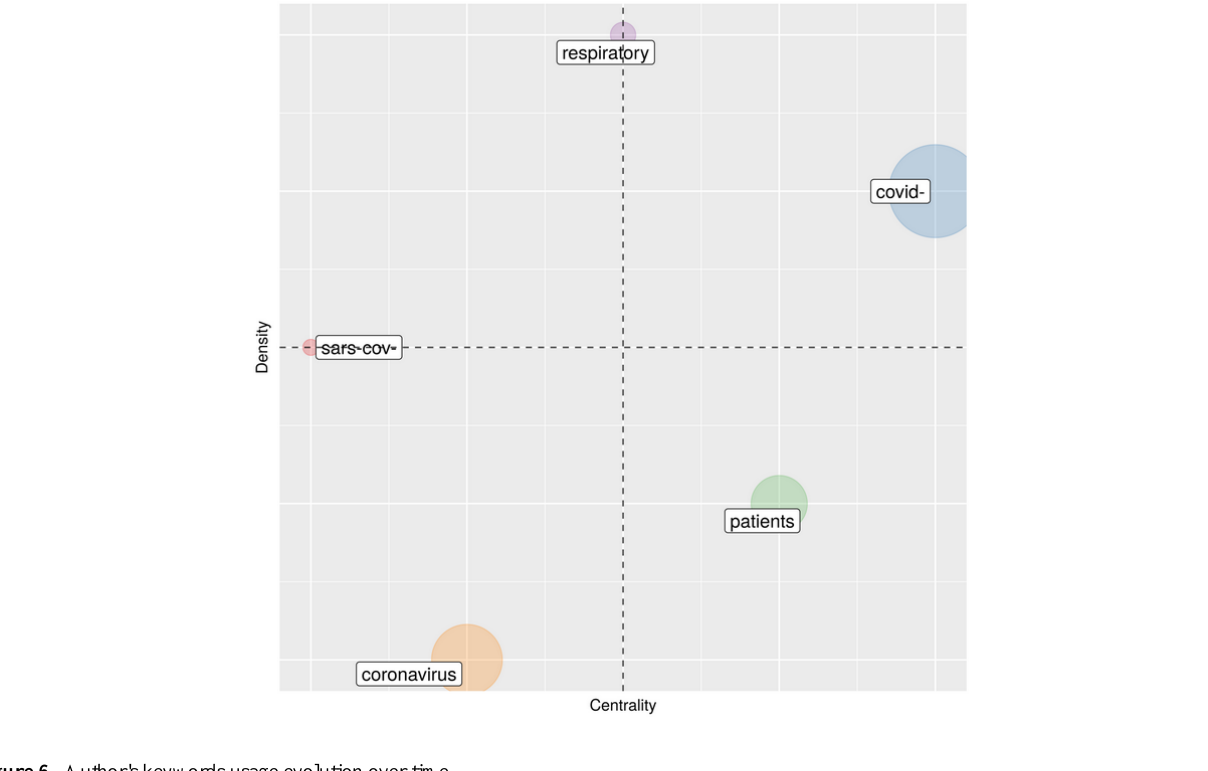
Figure 5. Thematic maps.